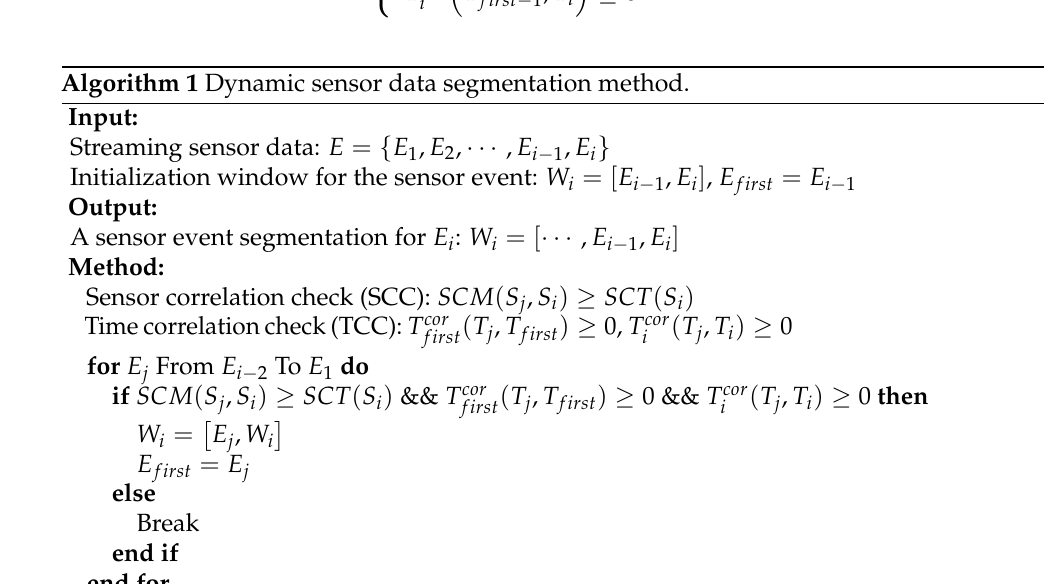
Algorithm 1 Dynamic sensor data segmentation